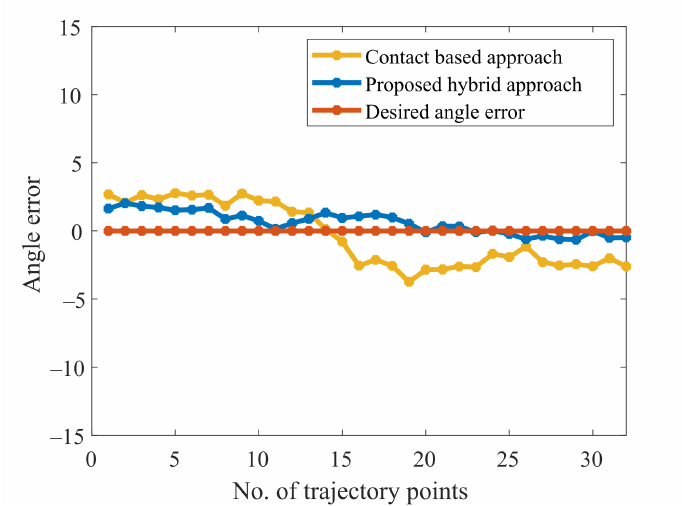
Figure 16. Absolute error comparison between contact-based and proposed